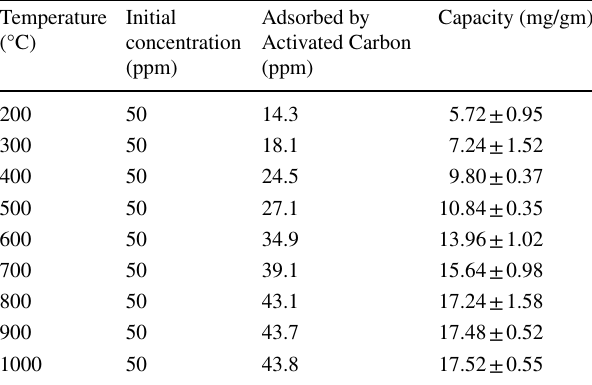
Table 2 Result of MB concentration before and after adsorption with